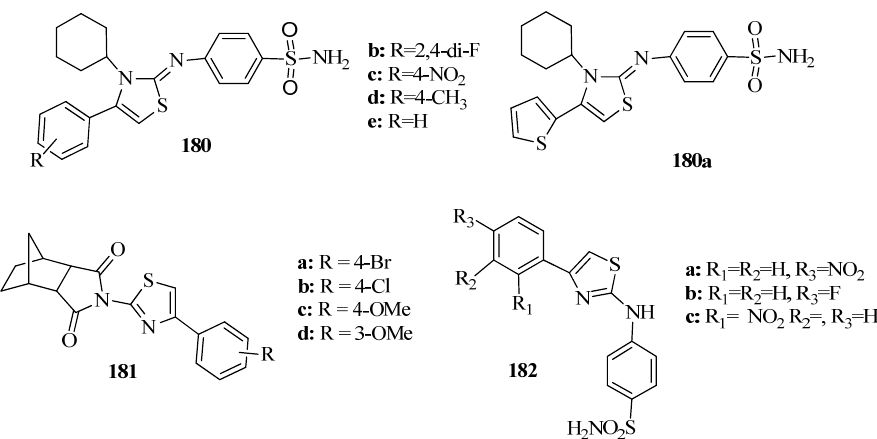
Figure 69. Structures of 4-[(3-cyclohexyl-4-aryl-2,3-dihydro-1,3-thiazol-2-ylidene) amino]benzene-1-sulfonamides, 2-(4-(aryl)thiazole-2-yl)-3a,4,7,7a-tetrahydro-1 H -4,7-methanoisoindole-1,3(2H)-dione, and sulfonamide-bearing thiazole derivatives.